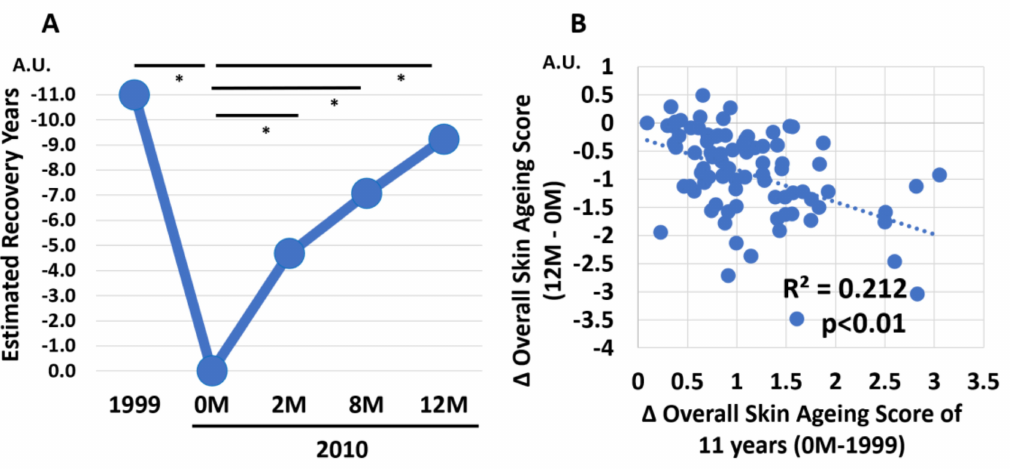
Figure 5. ( A ) Estimated number of recovered years in 1999 and in 2010 (at 0, 2, 8, and 12 M). All 86 subjects were treated with twice-daily application of G3 products for 12 M (0 M to 12 M). * p < 0.05. ( B ) Negative correlation ( p < 0.01) between change of Overall Skin Aging Score of 11 years (0 M—1999) and change of Overall Skin Aging Score (12 M–0 M) after twice-daily application of G3 products for 12 M.